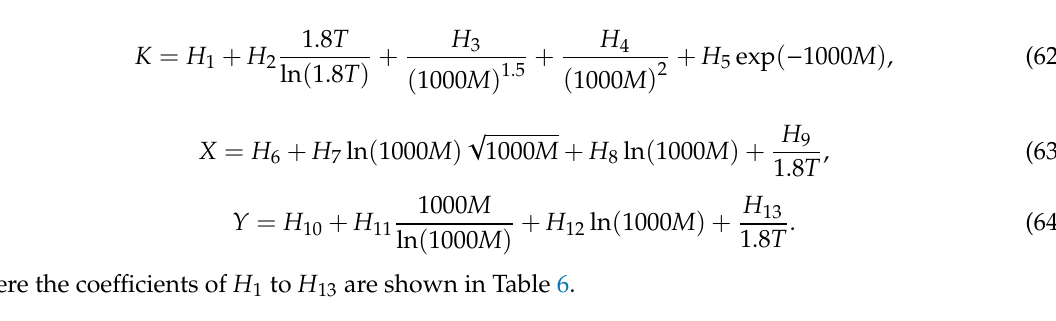
Table 6. The coe ffi cients of H 1 – H 13 in Equations (62)–(64). Coe ffi